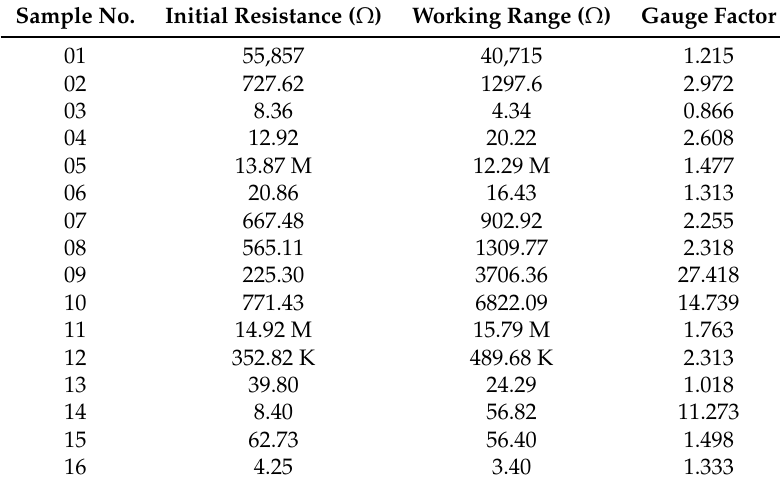
Table 2. Working range and gauge factor of